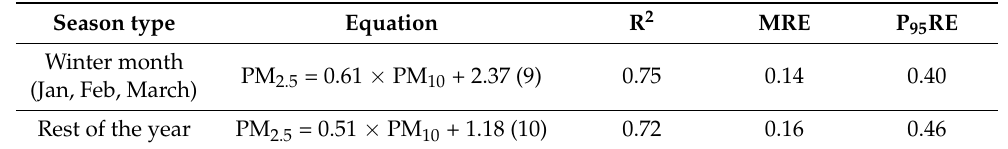
Table 3. Results of the different linear regressions by month